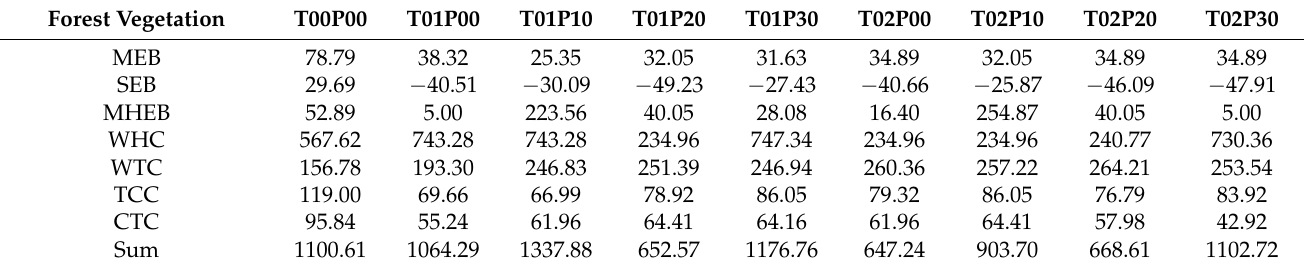
Table 5. CSP of forest vegetation in Yunnan Province under different simulation scenarios. Unit: